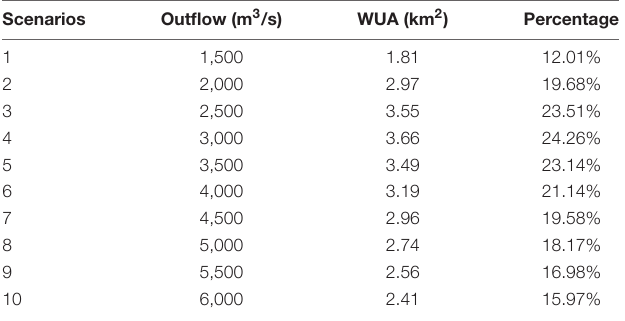
TABLE 1 | Weighted usable area (WUA) for different outflows from the Xiangjiaba Reservoir.